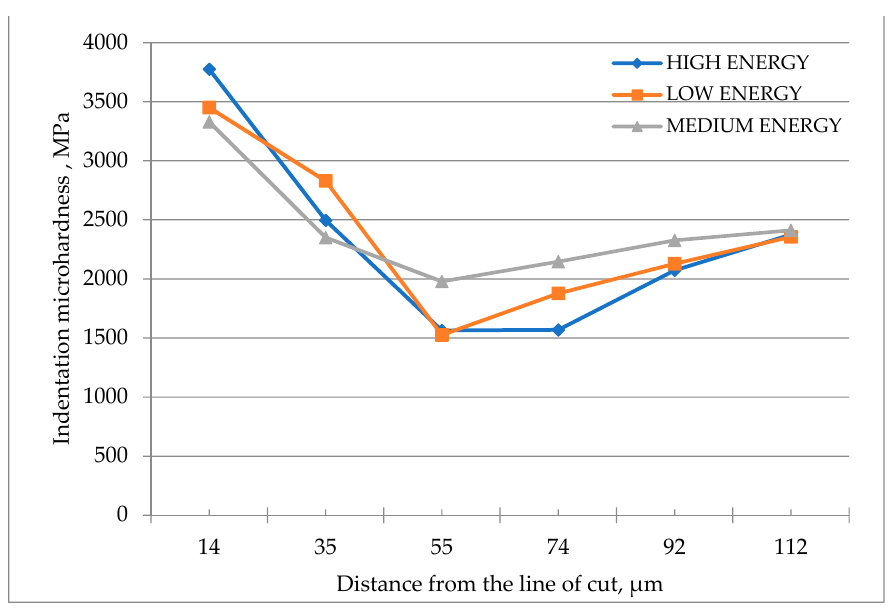
Figure 13. Metallographic microstructure with impressions at different distances from the line of cut (a pressure of 340 MPa and a cutting speed of 300 mm/min).